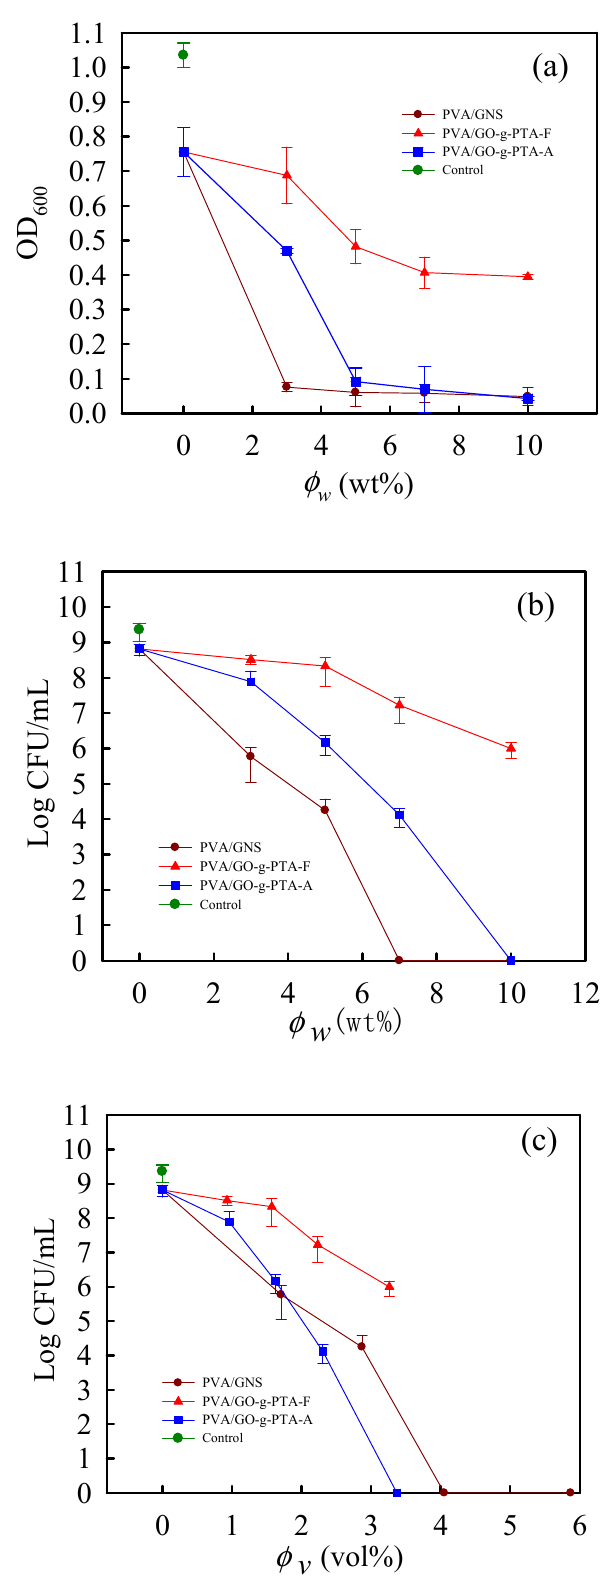
Figure 9. ( a ) Bacterial growth curves of the PVA / GNS, PVA / GO-g-PTA-F, and PVA / GO-g-PTA-A composite nanofiber mats versus the filler weight percentage determined by monitoring the OD 600